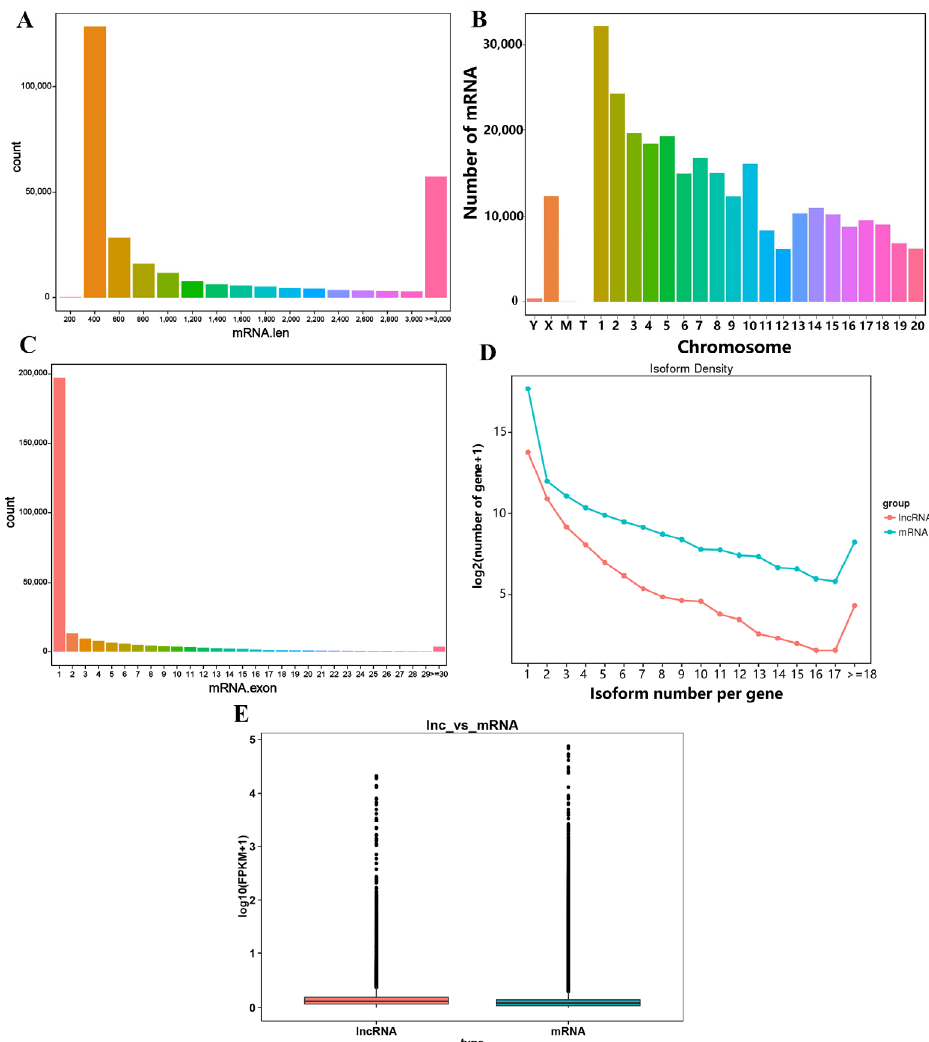
Figure 2. Results of mRNA sequencing in the adenohypophysis of rats after GnRH treatment. ( A ) Statistical analysis of mRNA length. ( B ) Location distribution of mRNA on rat chromosomes. ( C ) Statistical analysis of mRNA exon numbers. ( D ) mRNA/lncRNA alternatively spliced isoform levels. ( E ) Comparison of mRNA/lncRNA expression levels.